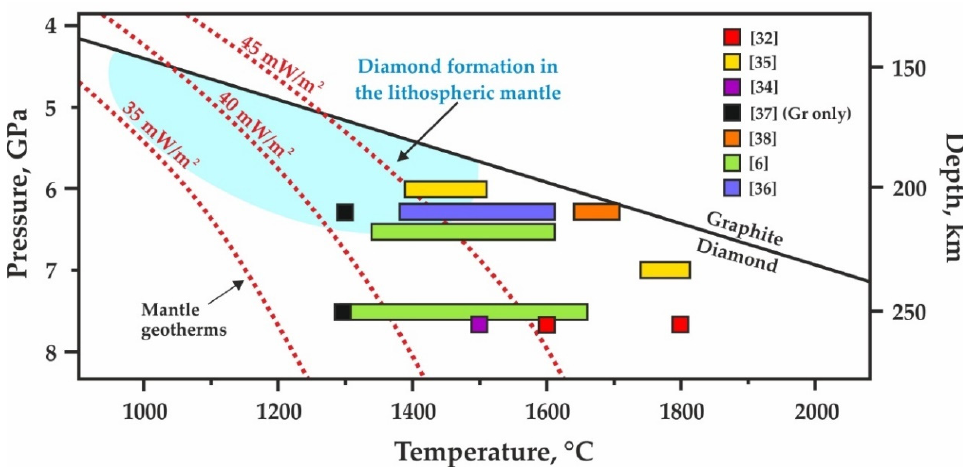
Figure 2. Experimentally determined P–T parameters of spontaneous diamond nucleation as a result of carbonate reduction. Additionally, the parameters of the formation of graphite as a result of carbonate reduction by the Fe-S-O melt are given.